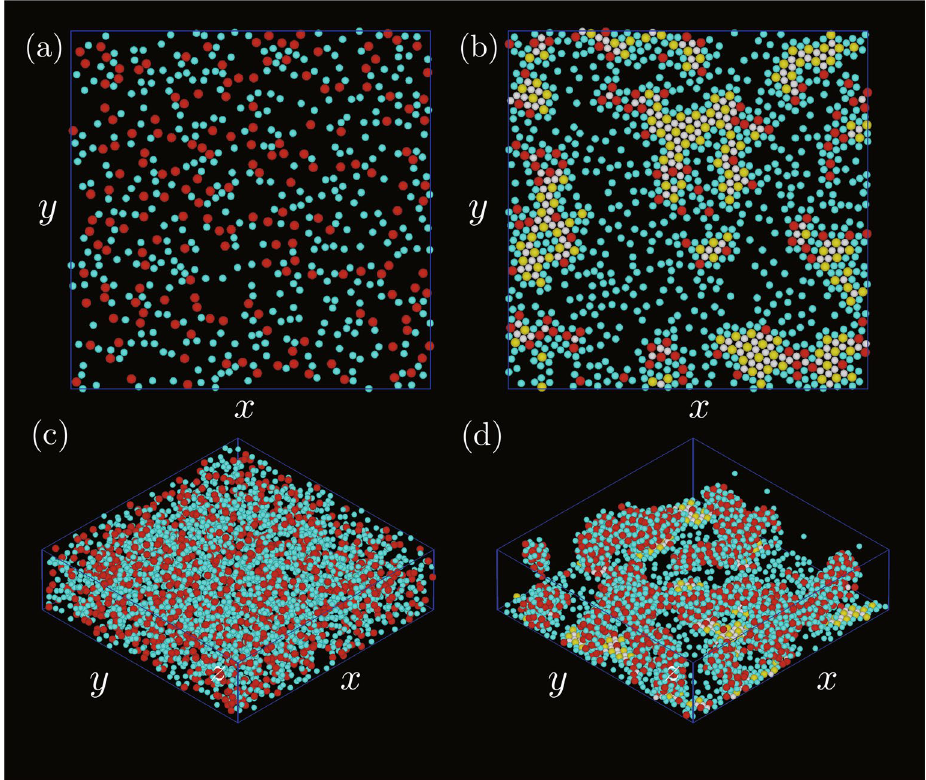
Figure 6. Two-dimensional structures created on the bottom wall for ε AB / k B T = ( a ) 2.0 and ( b ) 6.0, and three-dimensional views for ε AB / k B T = ( c ) 2.0 and ( d ) 6.0. The strength of interactions were ε AA /ε AB = ε BB /ε AB = 0.1 .